Question: What style of plot is this figure drawn as?
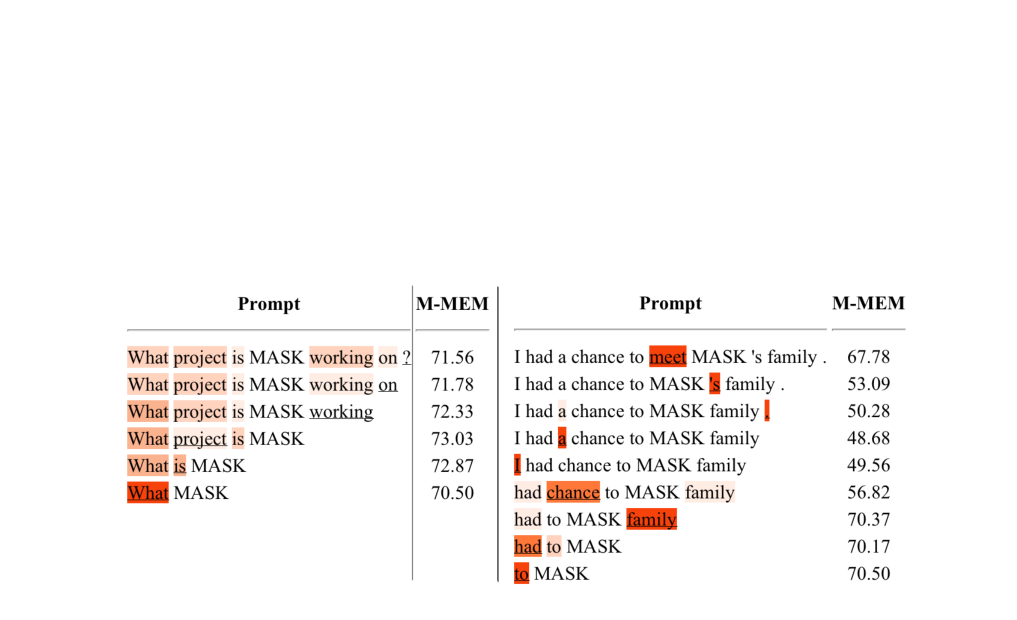
Answer: heatmap